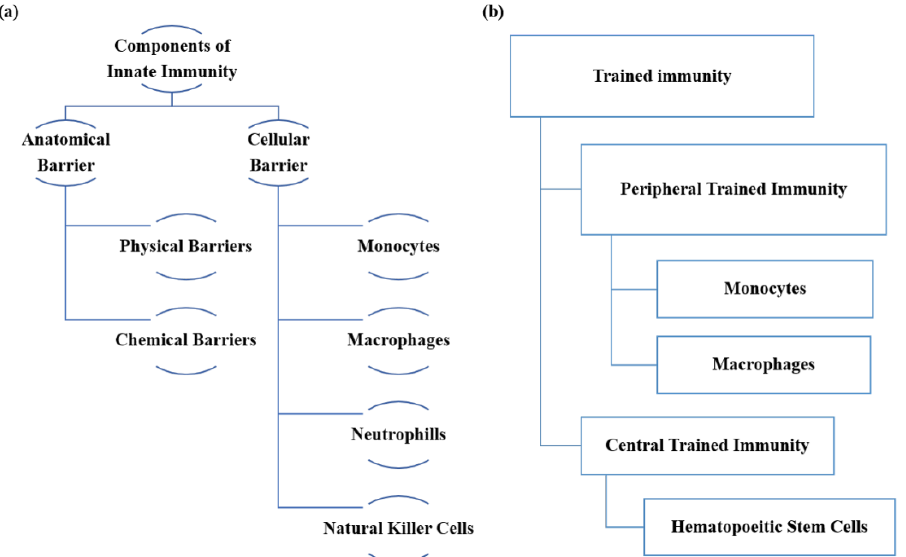
Figure 1. The components of innate immunity and trained immunity. ( a ) Schematic rep- different components of innate immunity. The innate immune system is divided into various subsets resentation of different components of innate immunity. The innate immune system is to generate the first line of defense against the array of invading pathogens. ( b ) Different cells of divided into various subsets to generate the first line of defense against the array of in- trained immunity are responsible for definitive vading pathogens. ( b ) Different cells of trained immunity are responsible for definitive functions.